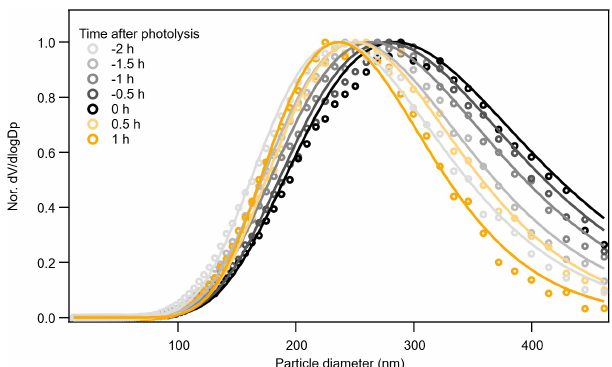
Figure 7. Evolution of the particle size distribution of the β - caryophyllene SOA during dark ageing and photolysis. The solid lines are log-normal